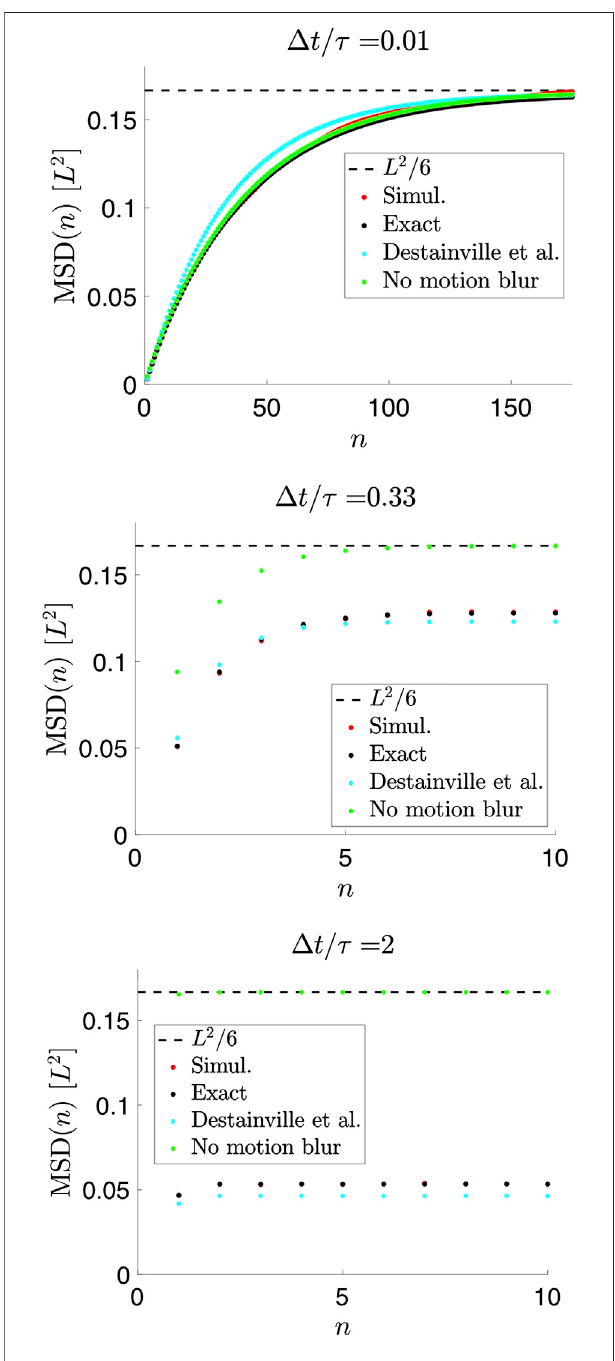
FIGURE 3 | Mean-squared displacements (MSDs) of measured positions for a Brownian particle in a 1D box for Δ t / τ (cid:2) 0.01 (top plot), 0.33 (middleplot), and 2 (bottom plot) with Δ t (cid:2) Δ t open .Each panel shows theMSD forthesimulateddata(red),theexactexpressionfrom Eq.22 (black),the expression from [18] stated in Eq. 25 (cyan), and the expression without the effect of motion blur from Eq. 24 (green). The horizontal black dashed line marks L 2 / 6, the limit reached for Δ t / τ → 0 and n → ∞